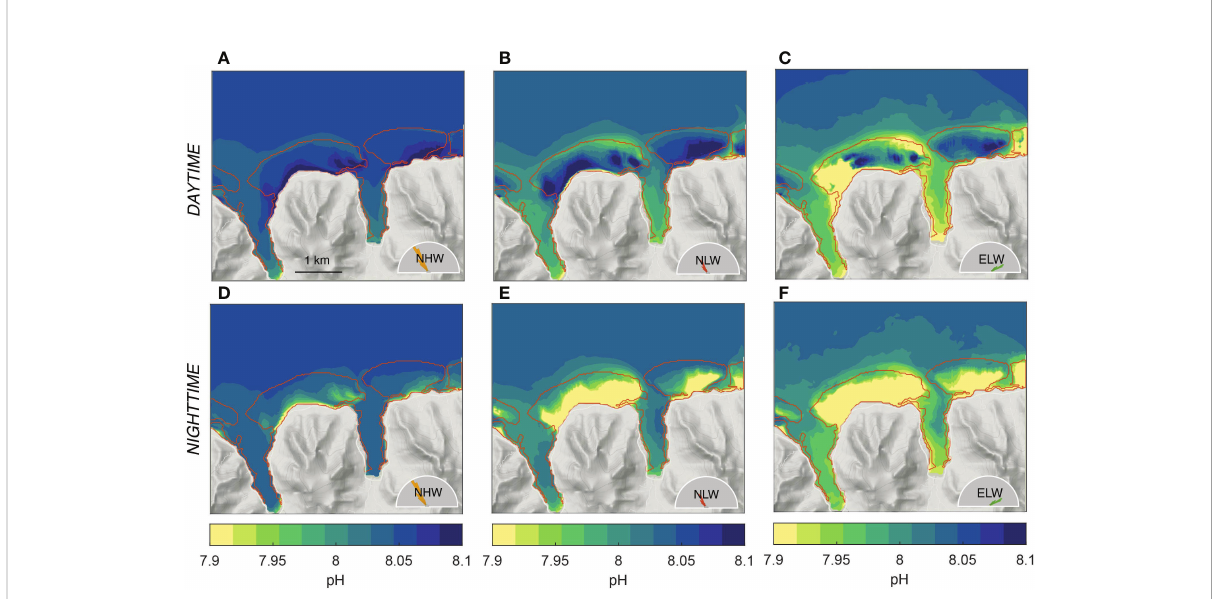
FIGURE 8 Simulated distribution of (top row) day- and (bottom row) nighttime pH for the three considered wave regimes, i.e., (A, D) northerly high wave (NHW) regime, (B, E) northerly low wave regime (NLW) and (C, F) northeasterly low wave regime (ELW). The weighted averages of these three scenarios for day and nighttime, respectively correspond to the annual mean shown in Figure 7H, K.